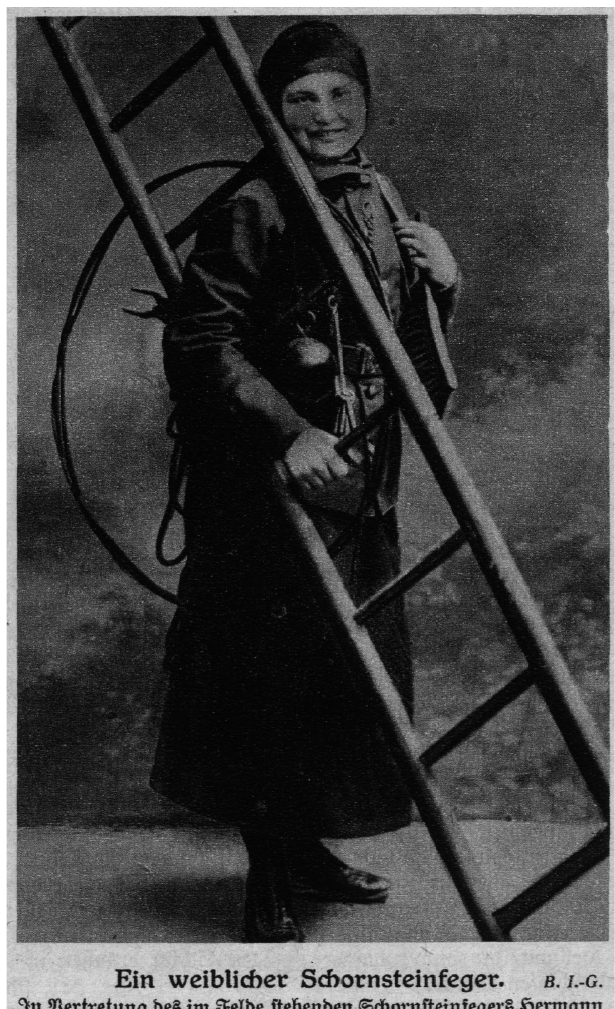
Ein weiblicher Schornsteinfeger (A Female Chimneysweep). 1916. Illustrierte Familien-Zeitung 18 (30. April, 1916), p. 140. 12.5 x 8